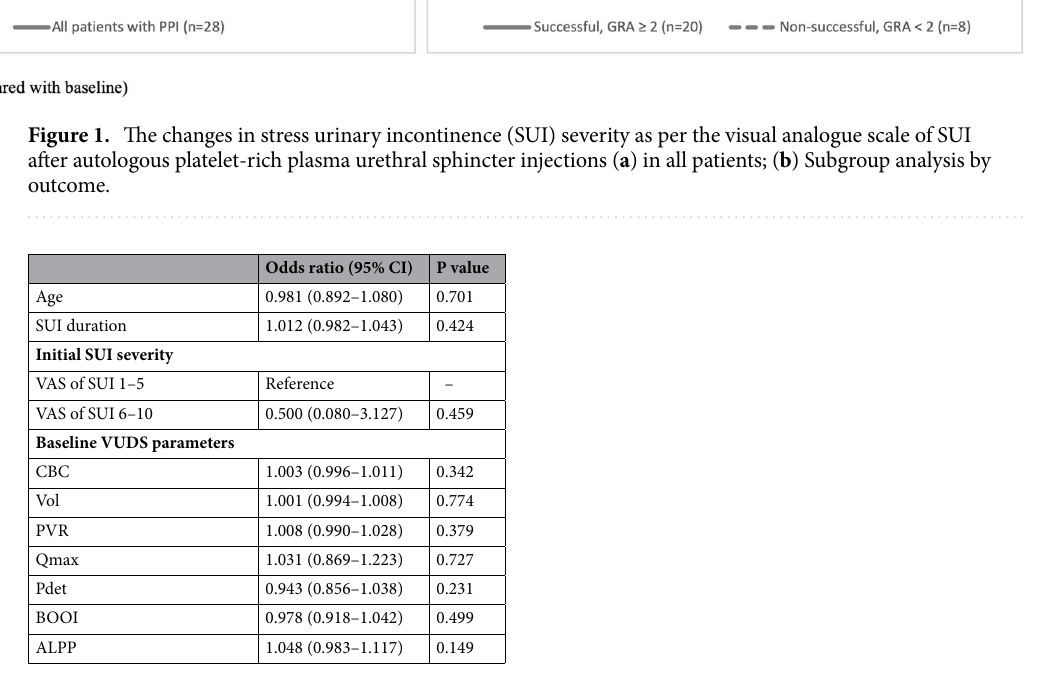
Table 2. Logistic regression analysis for predictors of successful outcome. ALPP abdominal leak point pressure; BOOI bladder outlet obstruction index; CBC cystometric bladder capacity; Pdet detrusor pressure at maximum flow rate; PVR postvoid residual; Qmax maximum flow rate; VAS of SUI visual analogue scale of stress urinary incontinence severity; Vol voided volume; VUDS videourodynamic